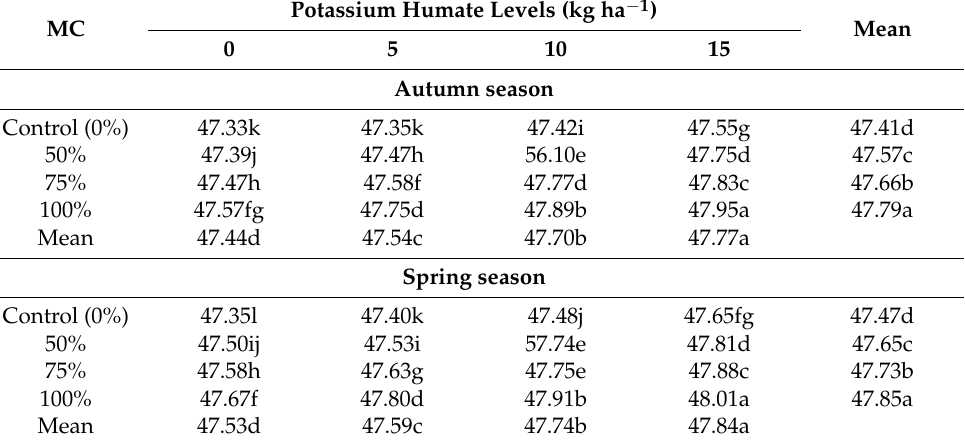
Table 4. Harvesting index of tomato as affected by various levels of K-humate and MC under the field conditions during autumn.